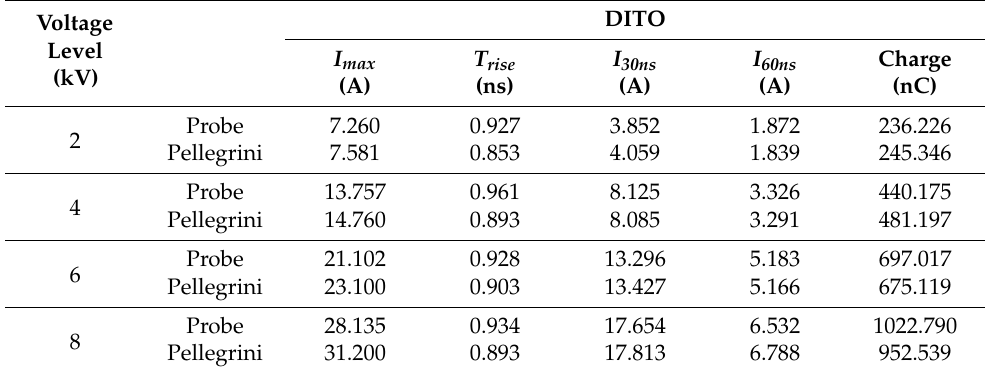
Table 3. Reconstructed and reference ESD current parameters for the EM TEST Dito ESD generator [19].